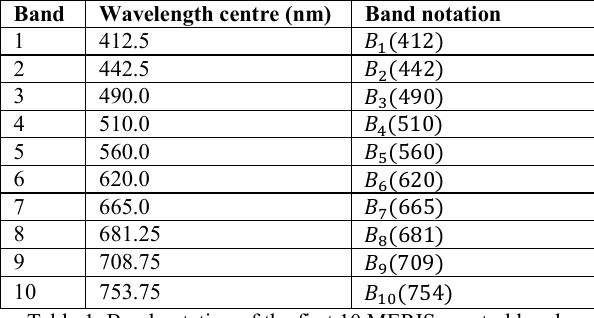
Table 1 . Band notation of the first 10 MERIS spectral bands